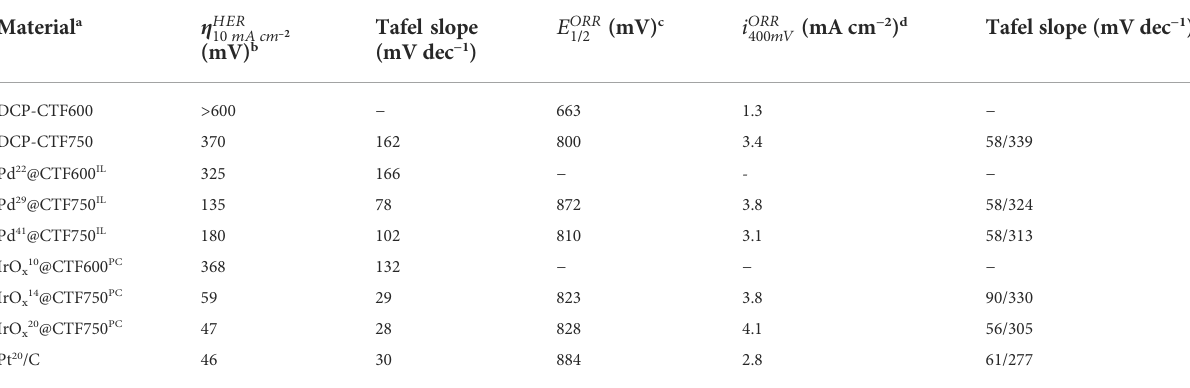
TABLE 3 HER and ORR parameters of the Pd- and IrO x @CTF